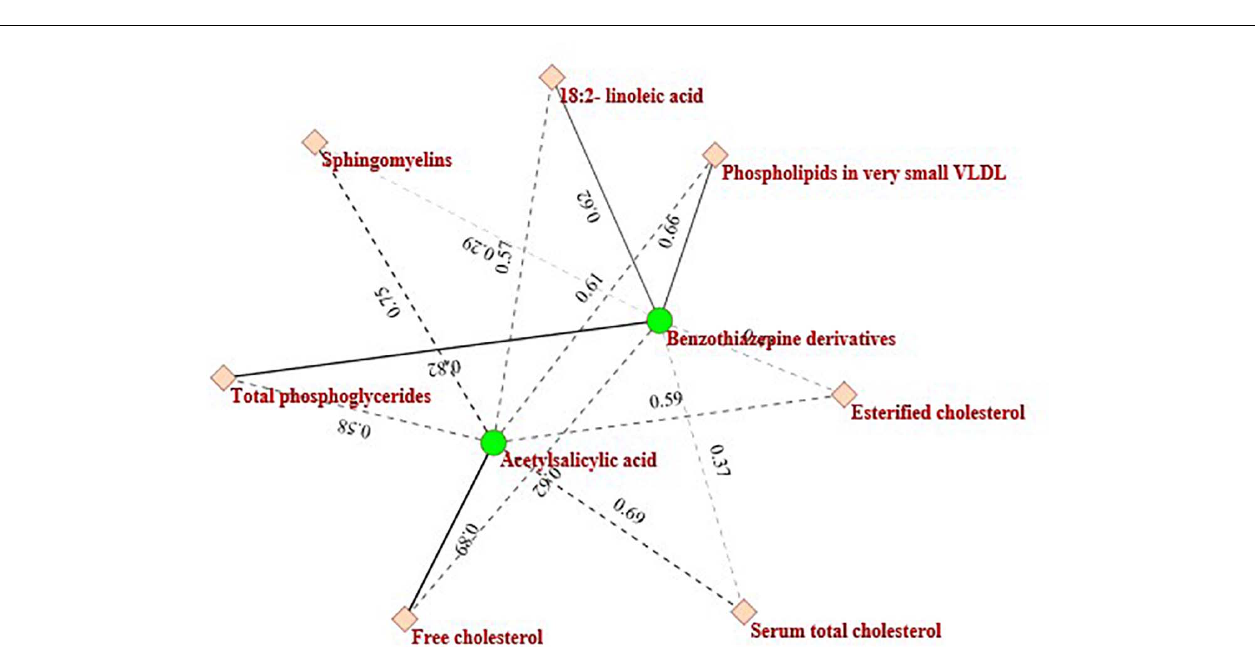
FIGURE 6 | The sub-network consists of two drugs and seven